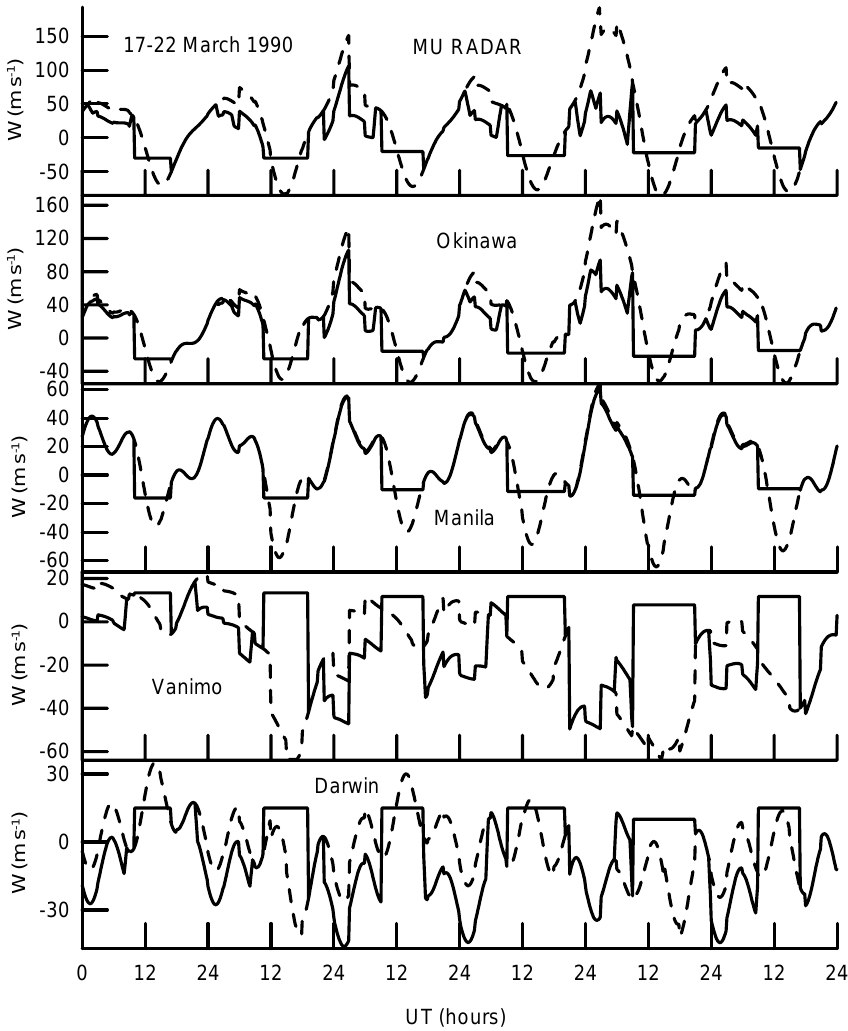
Fig. 9. Diurnal variations of the modeled meridional uncorrected (dashed lines) and corrected (solid lines) HWM90 neutral wind at 300km altitude during 17–22 March 1990 over the MU radar, and over the Okinawa, Manila, Vanimo, and Darwin ionosonde stations. The meridional wind is directed northward for W > 0 and southward for W < 0 relative to the geographic equator.